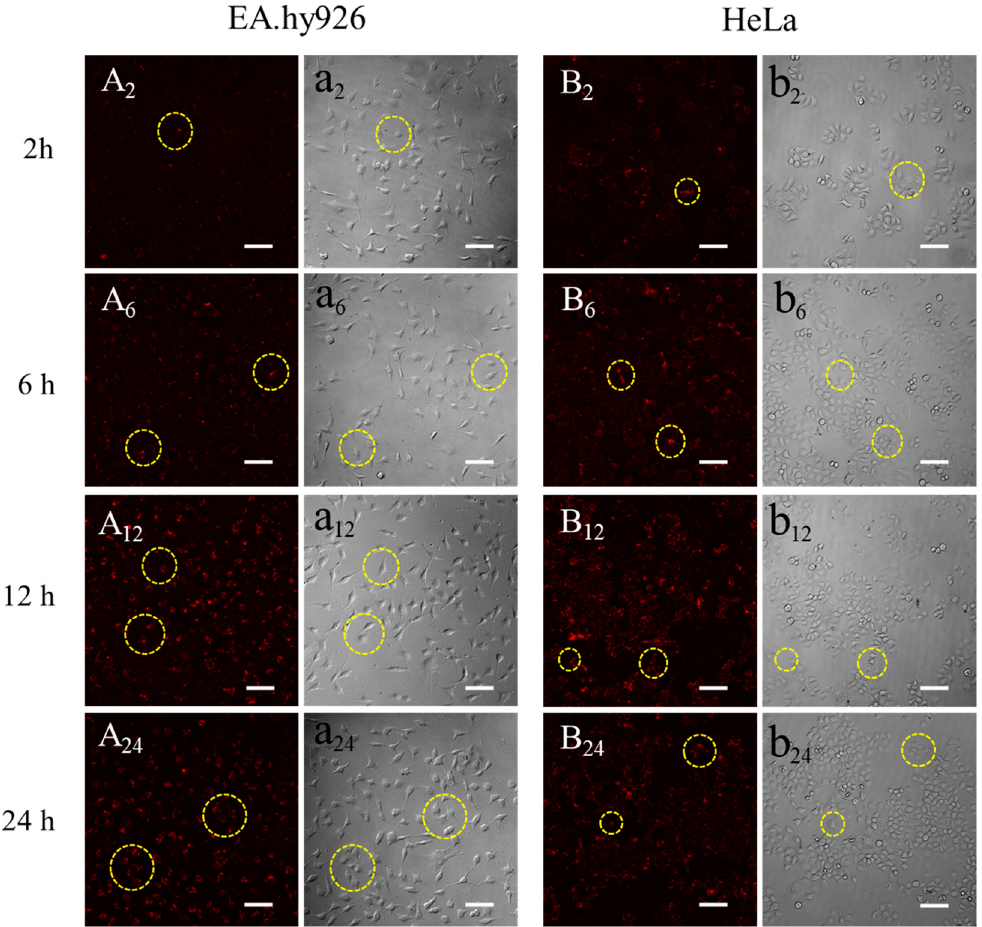
Figure 9. Fluorescent images of QD-SFNPs when cultured with ( A , a ) EA.hy926 cells and ( B , b ) HeLa cells. A and B denote the fluorescent field while a and b denote the bright field, and 2, 6, 12, and 24 denote incubation time was 2 h, 6 h, 12 h, and 24 h, respectively. Scale bar: 100 μ m. The yellow circles indicated that the QD-SFNPs were more likely to be internalized by the cells.